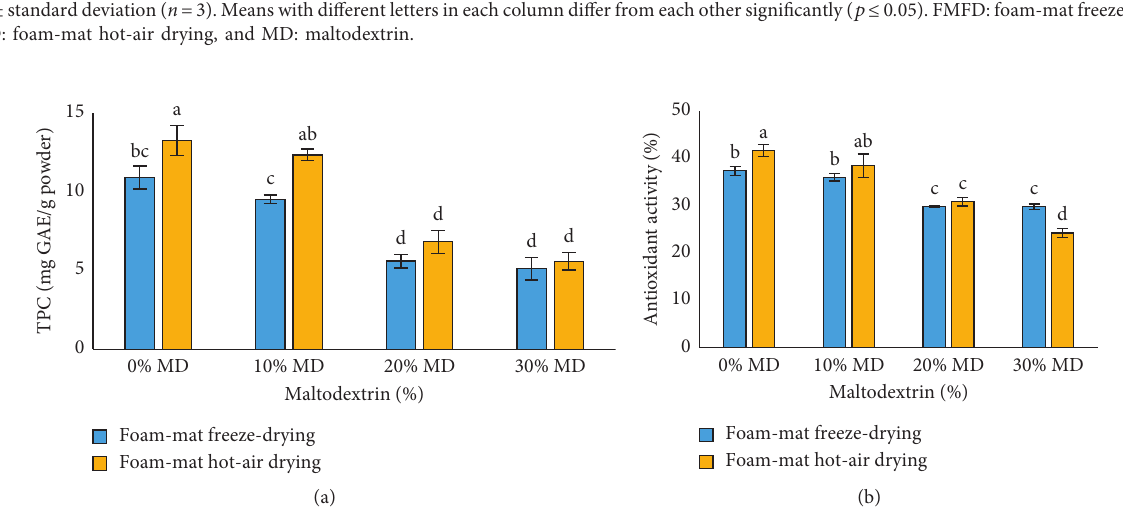
Figure 2: Effect of the drying method and maltodextrin concentration on the chemical properties of foam-mat-dried instant beverage powders based on red beetroot extract. (a) TPC and (b) antioxidant activity. Mean ± standard deviation ( n � 3). Different small letters on each column show significant statistical differences.